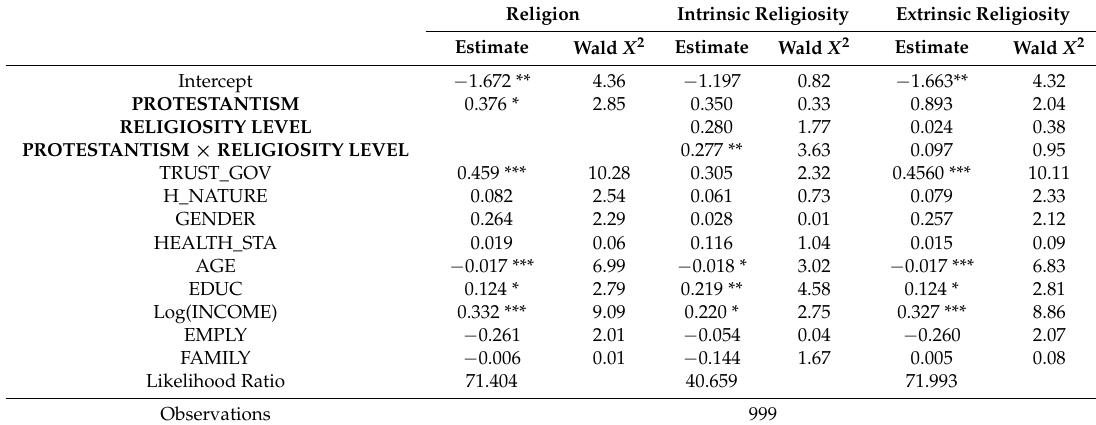
Table 9. The effect of Protestantism and religiosity level on the willingness to donate